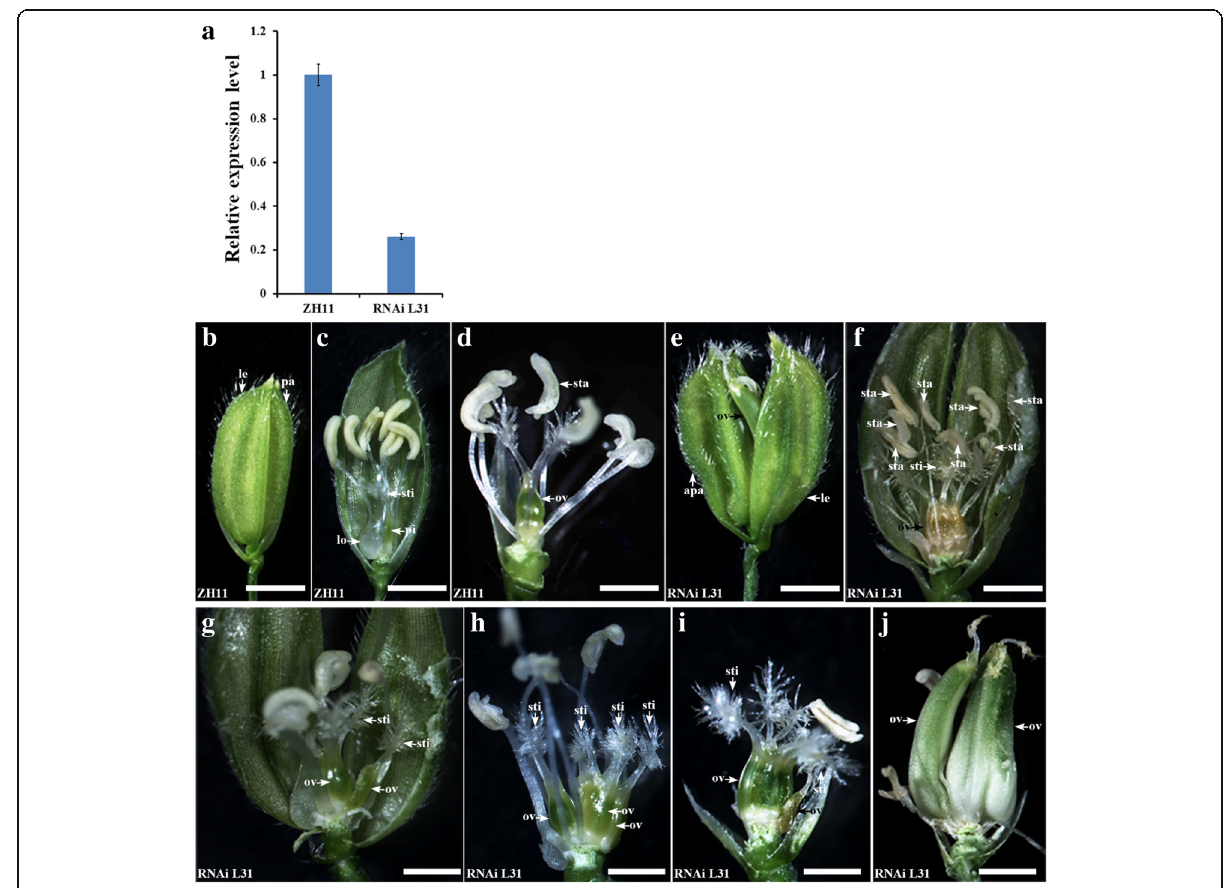
Fig. 4 Phenotypes of flowers in RNAi L31 transgenic plants. a Expression levels of OsRopGEF7B in RNAi L31 compared with wild type (ZH11). ( b - j ) Floral phenotypes of RNAi L31 compared with wild type. Lemmas/paleae and stamens were partially or totally removed to show the inner organs. b - d Wild type flowers. e - j RNAi L31 flowers with various phenotypes. e A flower with one normal lemma and one abnormal palea, and the ovary coming out from the shells. f A flower with eight stamens. g A flower with two ovaries. g A flower with more than two ovaries ( i ) A flower with multiple stigmas. j A flower with two enlarged different sized ovaries with atrophic stigmas. Bars = 1